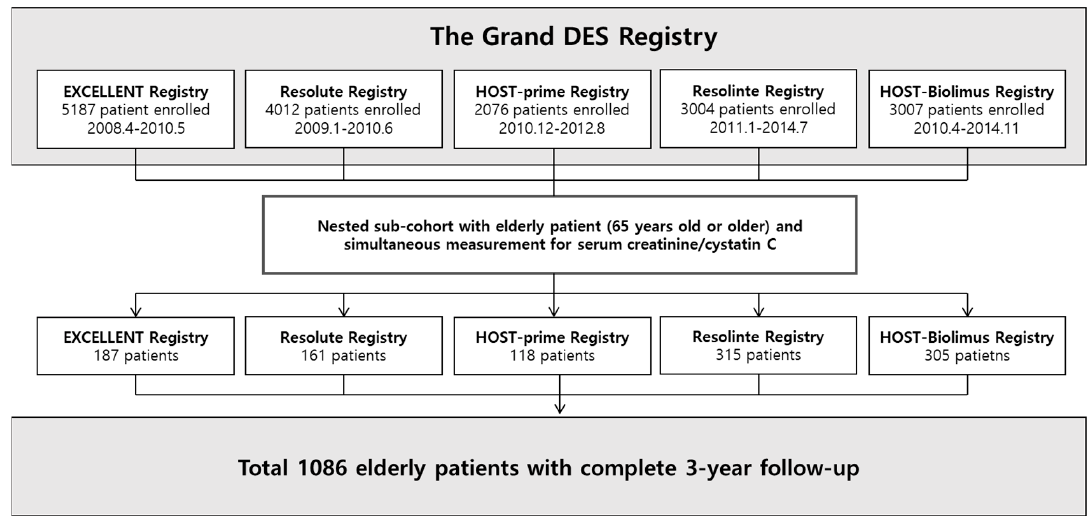
Figure 1. Study flow of the nested sub-cohort. The Grand drug-eluting stents (DES) registry is a multicenter nation-wide pooled registry of the EXCELLENT registry, HOST-PRIME registry, RESOLUTE-Korea registry, RESOLINTE registry, and HOST-BIOLIMUS registry in Korea. Among the total population of the Grand DES registry, 1086 patients who had serum creatinine and cystatin C data and aged 65 or older were analyzed in this study. DES = drug-eluting stent.